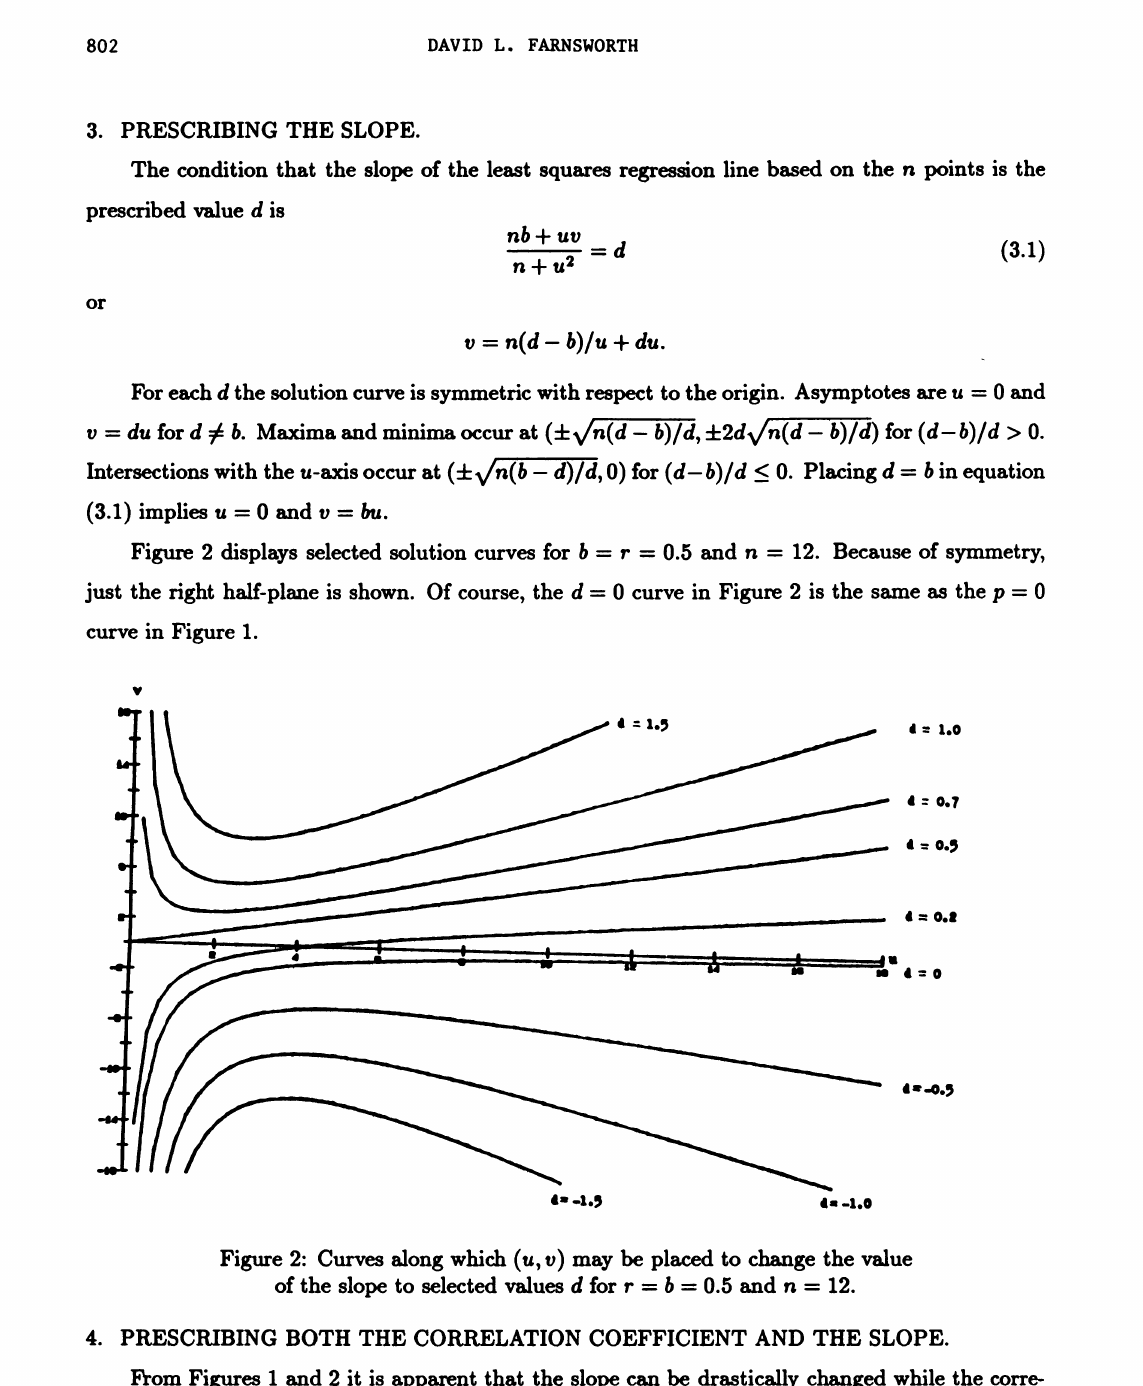
Figure 2: Curves along which (u, v) may be placed to change the value of the slope to selected values d for r b 0.5 and n